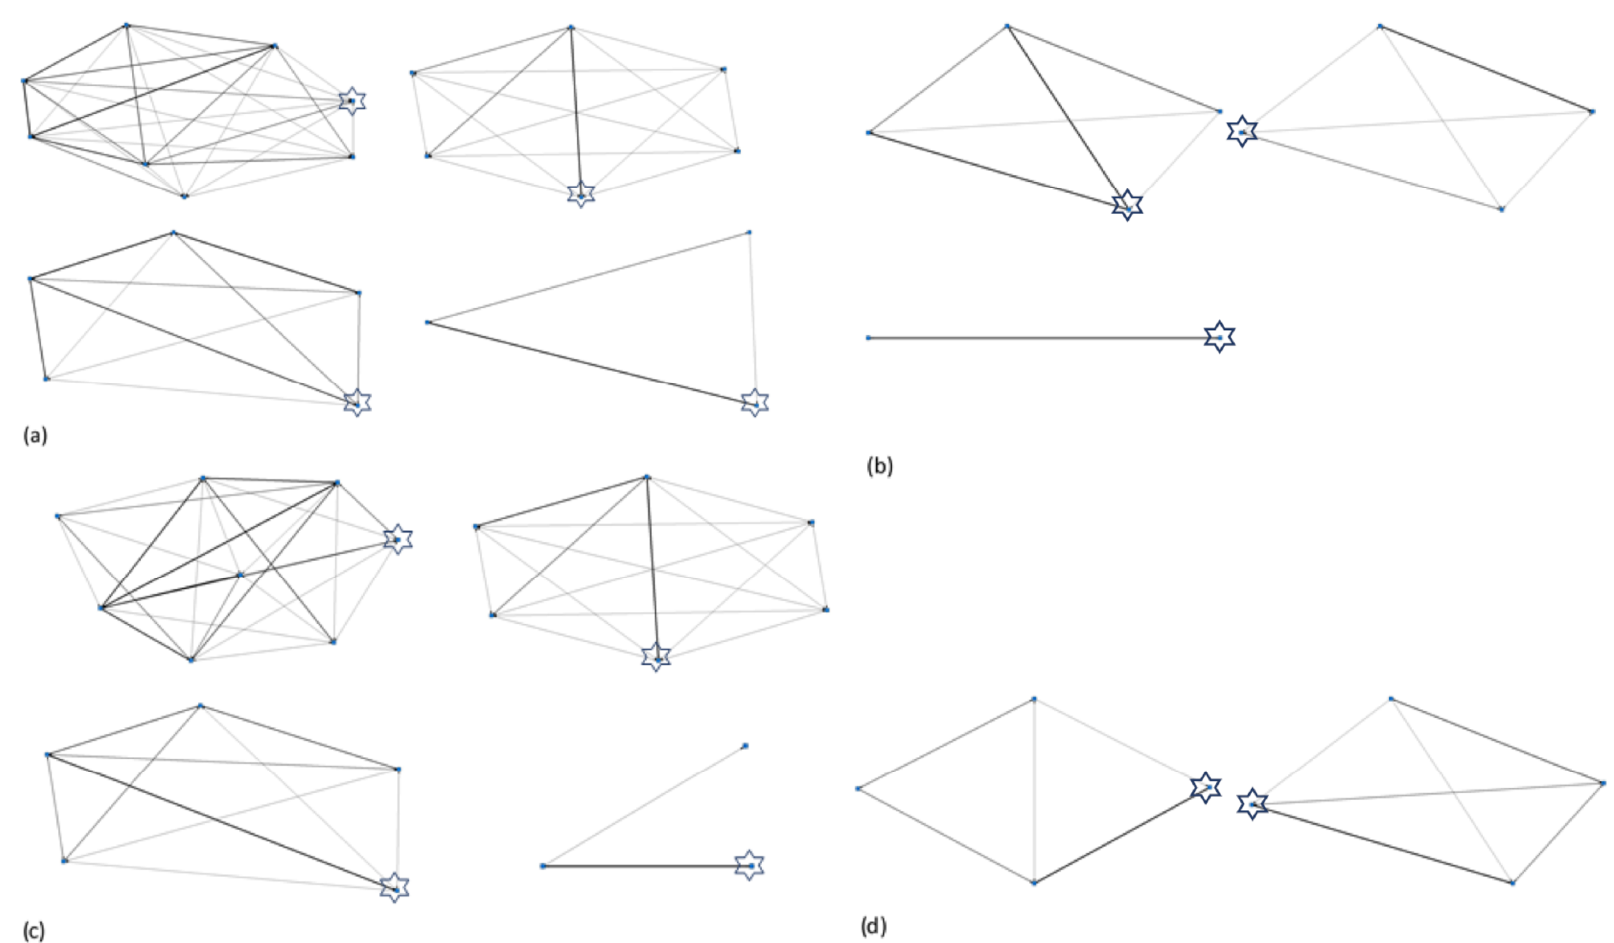
Figure 2. Sociograms depicting positive interaction networks in the study elephants. ( a ) Asian elephant positive non-physical interaction network, ( b ) African elephant positive non-physical interaction network, ( c ) Asian elephant positive physical interaction network, and ( d ) African elephant positive physical interaction network. Matriarch or elephant considered to be the most dominant herd member is highlighted with a star.